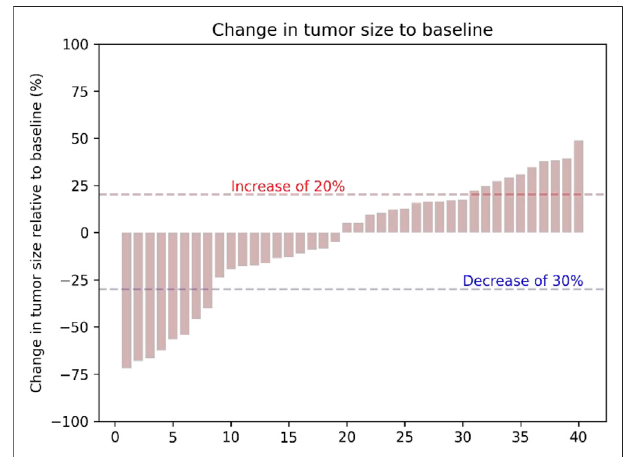
FIGURE2| Tumorpercentagechangesfromthebaselineintermsofthe target lesion sizes.